Question: Sum up the contents of this chart in one sentence.
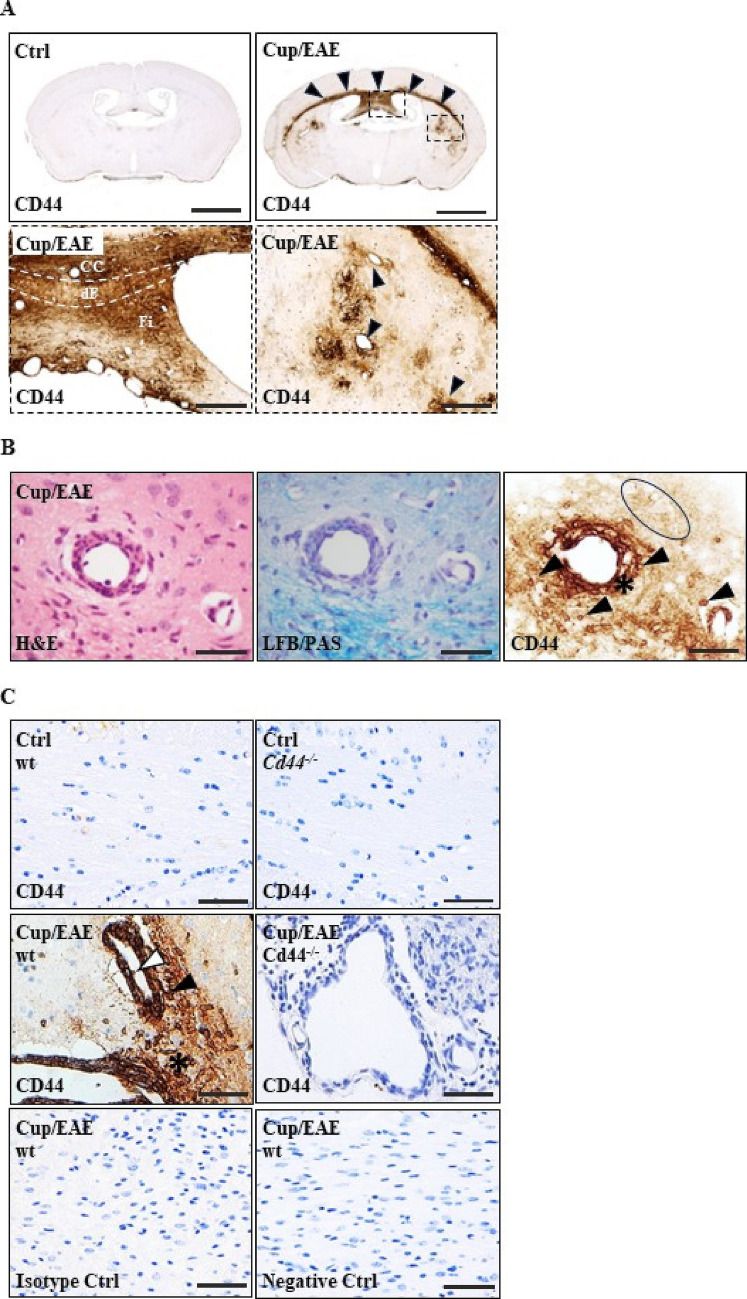
Answer: CD44 expression in Cup/EAE and antibody specificity. A Representative anti-CD44 staining in control (Ctrl) and Cup/EAE mice showing diffuse CD44 immunoreactivity in lesions of the CC, dorsal fornix (dF), fimbriae (Fi), and perivascular cuffs (PVCs), indicated by closed arrowheads. Scale bar: 1 mm; insets: left 250 µm, right 100 µm. B H&E staining of a PVC in Cup/EAE mice with adjacent LFB/PAS showing partial demyelination. CD44 staining localizes to luminal and abluminal (closed arrowheads) surfaces as well as diffusely (asterisk and ovoid). Scale bar: 50 µm. C Antibody specificity controls showing no CD44 signal in wt, Cd44 −/− isotype, or no primary antibody (negative) controls, while strong staining is observed in PVCs of Cup/EAE spinal cord. Scale bar: 50 µm